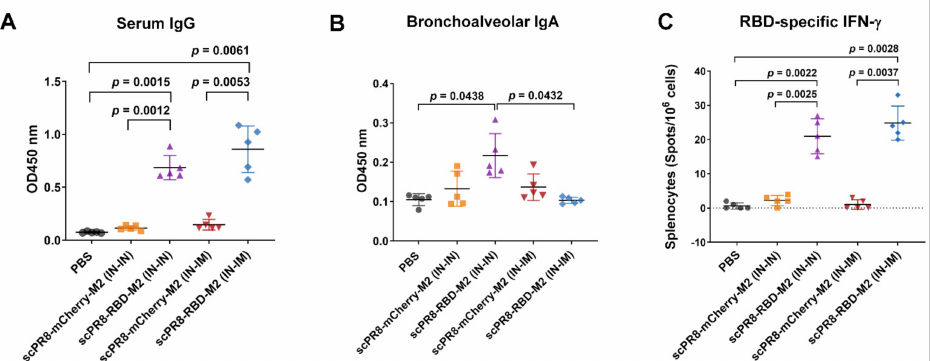
Figure 5. Cell-mediated and humoral immune responses elicited by scPR8-RBD-M2 in mice. Female BALB/c mice were intranasally (IN-IN) or intranasally primed followed by intramuscularly (IN-IM) boosted with 1 × 10 5 TCID 50 / mL . PBS and scPR8-mCherry-M2 were used as controls. At 21 days post-second immunization, ( A ) titers of serum IgG (at 1:250 dilution) and ( B ) bronchoalveolar IgA antibodies (at 1:25 dilution) against SARS-CoV-2 RBD were determined by ELISA. ( C ) Splenocytes from vaccinated mice were stimulated with SARS-CoV-2 spike peptide pool. SARS-CoV-2 RBD specific T cells were quantified using ELISPOT assay. Error bars represent the mean ± standard error of mean. p values < 0.05 were considered statistically significant.